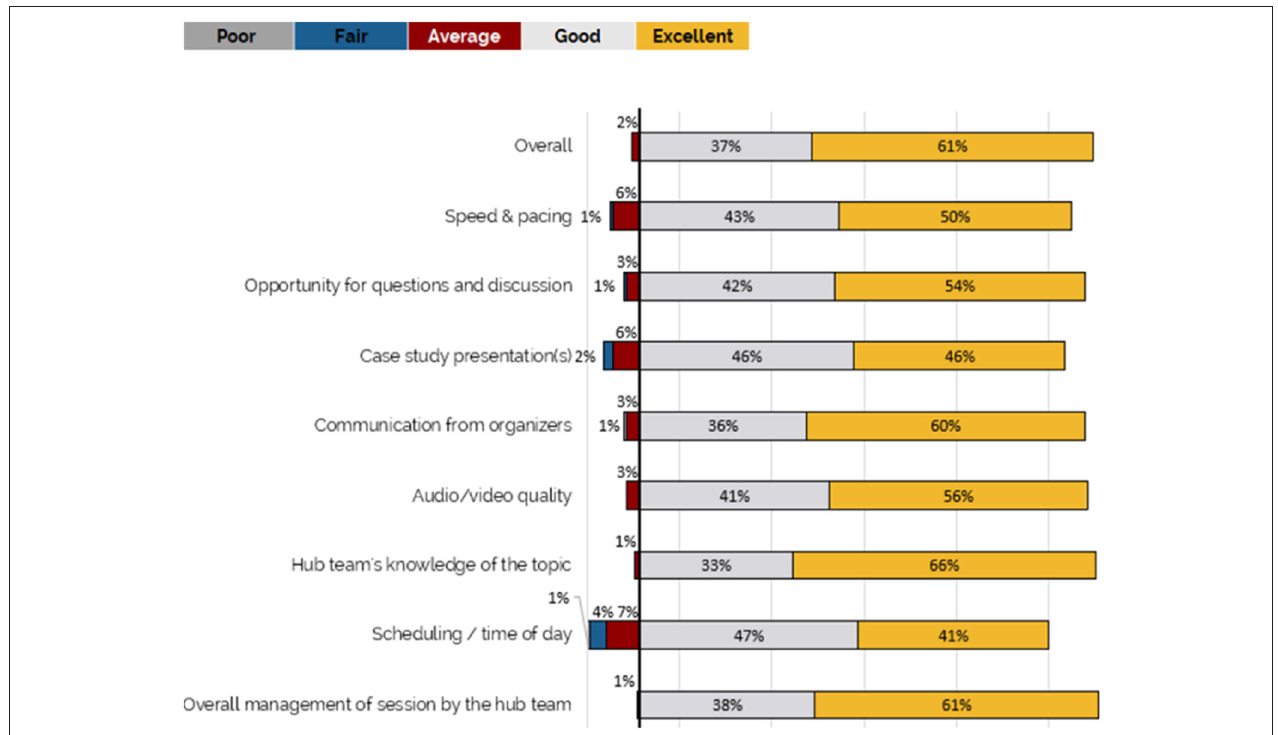
FIGURE 2 | Participant